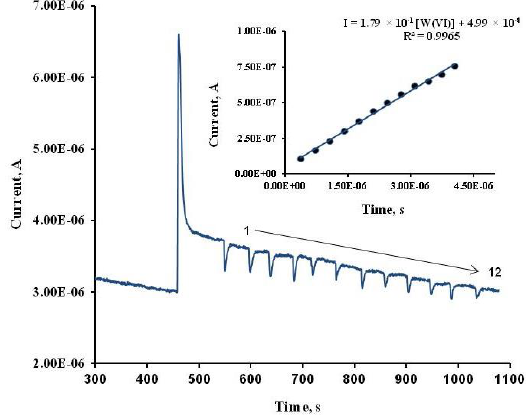
Figure 1. Chronoamperogram registered using an ALP-based biosensor under the optimum conditions (applied potential, +0.20 V vs. Ag/AgCl SPE; supporting electrolyte pH 8.00 (Tris HCl buffer, 0.36 M total Cl − ) and 2-phospho- L -ascorbic acid trisodium salt 0.32 mM, in the W(VI) concentration range from 3.0 µM to 30.0 µM. Inset figure, a calibration curve for twelve aliquot W(VI) additions under optimum